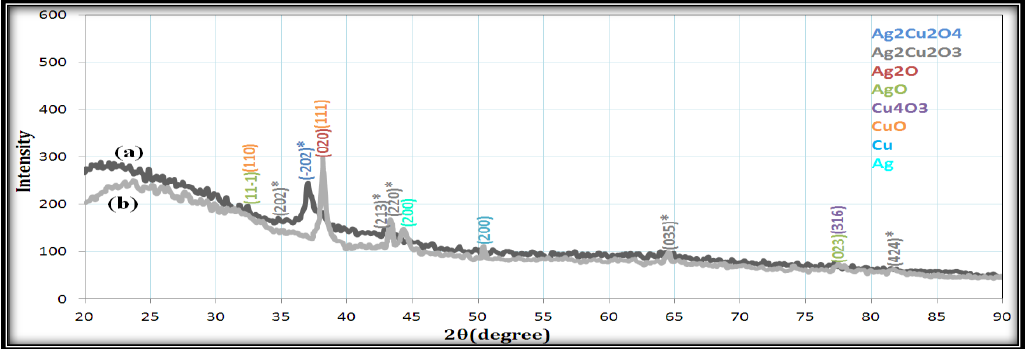
Cu O film sintered at 200 °C (a) deposited at room 2 2 4